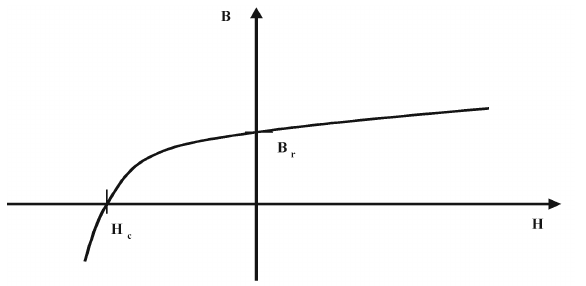
Figure 6: Permanent Magnet Demagnetization function was used (also used in the Jiles Atherton Model [12, 13, 14]), with an H axis offset added to provide this behaviour. The listing of this model is given in Figure 7.